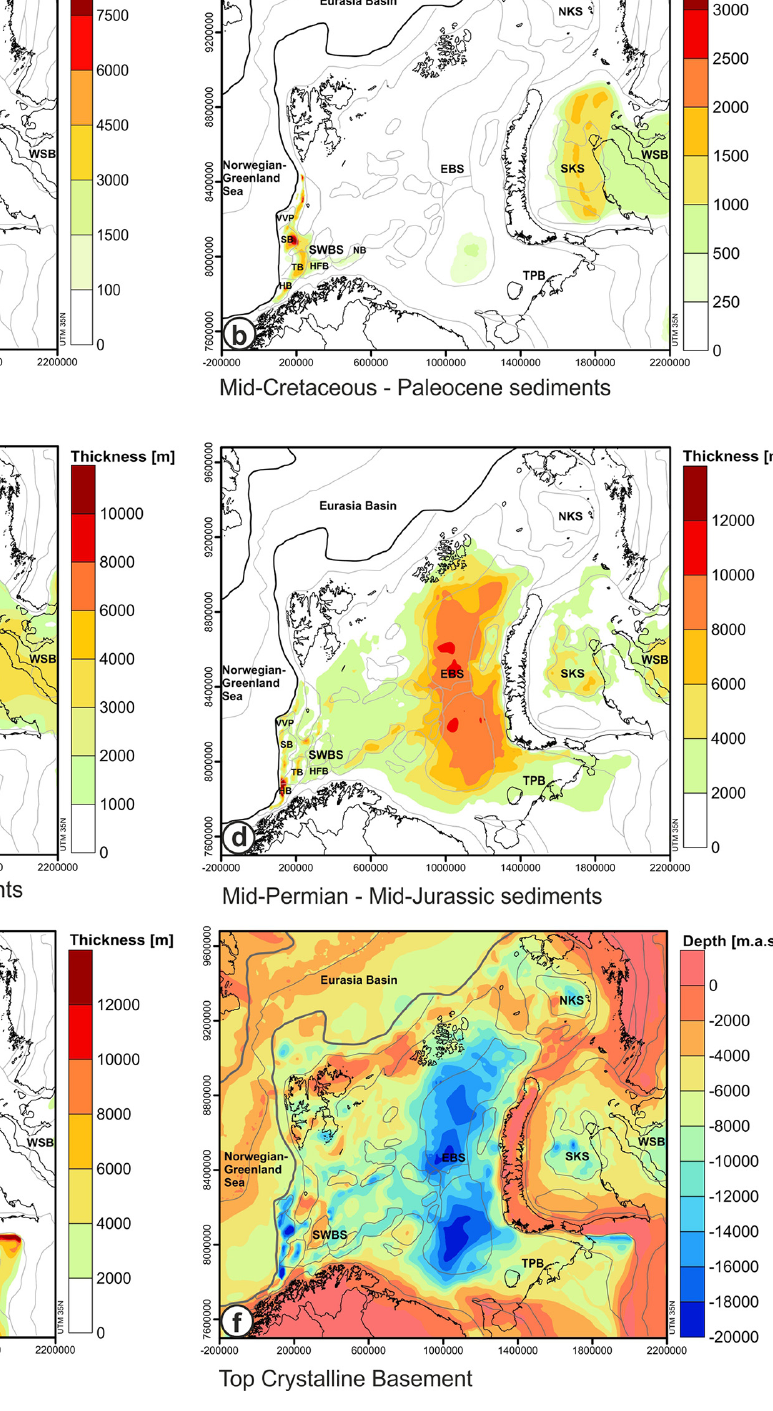
Figure 4. Thickness distribution of the megasequences and the depth to the top crystalline crust: (a) Earliest Eocene to Present; (b) Mid- Cretaceous–Paleocene; (c) Mid-Jurassic–Mid-Cretaceous; (d) Mid-Permian–Mid-Jurassic; (e) Pre-mid-Permian; (f) depth to the top crys- talline crust. The grey lines delineate structural features in the study area (for legend see Fig. 1b). See Table 1 for database. (EBS) – eastern Barents Sea; (NKS) – northern Kara Sea; (SB) – Sørvestsnaget Basin; (SKS) – southern Kara Sea; (SWBS) – southwestern Barents Sea; (TPB) – Timan–Pechora Basin; (VVP) – Vestbakken Volcanic Province; (WSB) – West Siberian Basin.